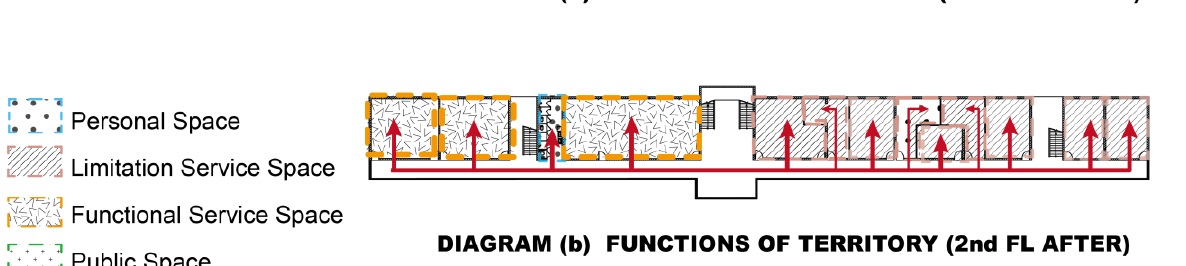
Figure 17. Campus Transformation of Pingtung Education Innovation Unit.